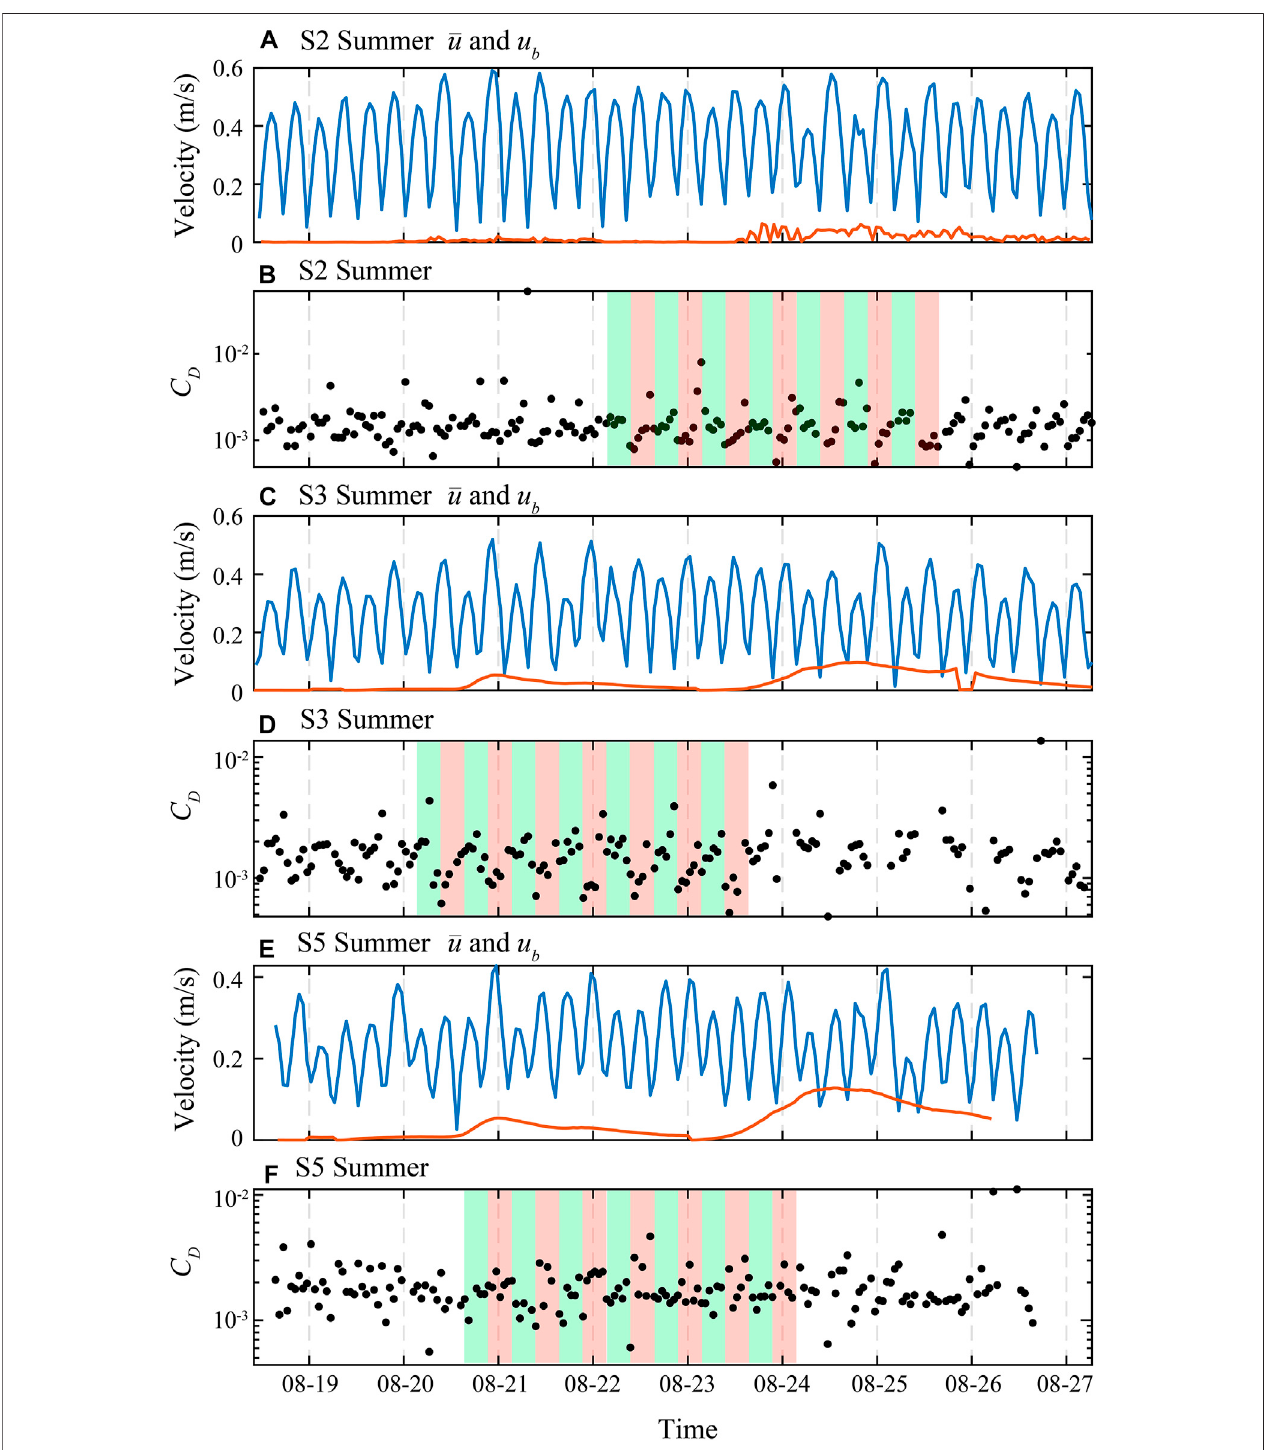
FIGURE 6 | Time series of (A,C,E) ADV ’ s burst mean velocity ( (cid:1) u , blue line) and bottom wave orbital velocity ( u b , orange line) and (B,D,F) drag coef fi cient, C D , estimated using ADV ’ s burst mean velocity at S2, S3, and S5 in summer. Green and red shaded areas denote periods of ebb and fl ood tides, respectively.